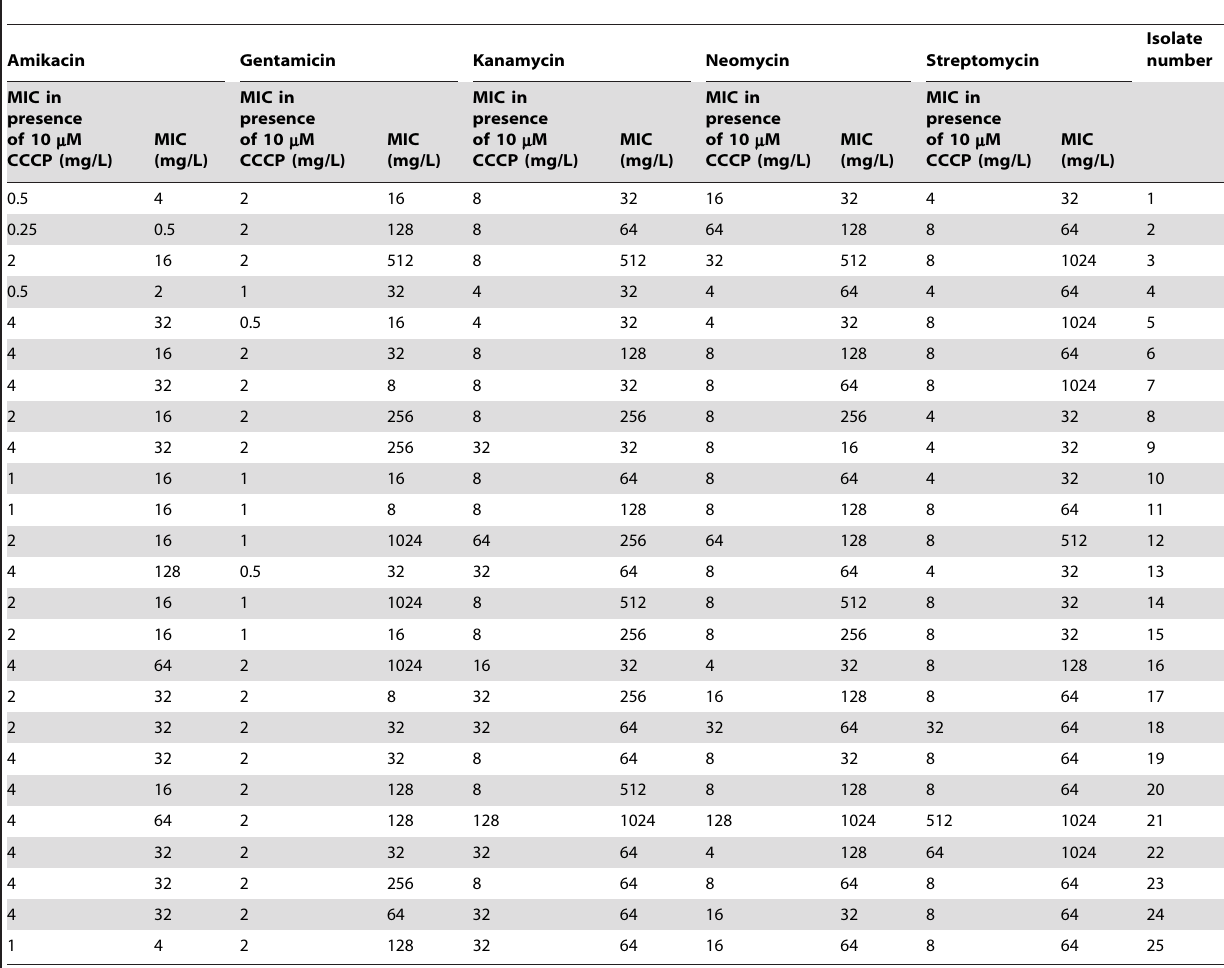
Table 5. Effect of adding CCCP on antibiotic resistance pattern of Pseudomonas aeruginosa isolates. Amikacin Gentamicin Kanamycin Neomycin Streptomycin